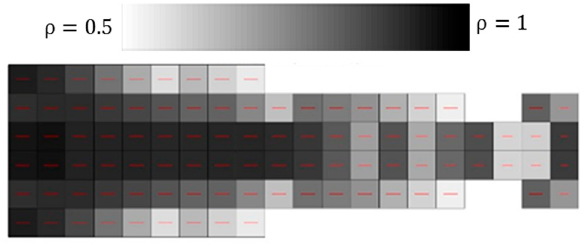
Figure 11. Topology result for Case 1 (top view). Elements with ρ e ≤ 0.5 are not shown.